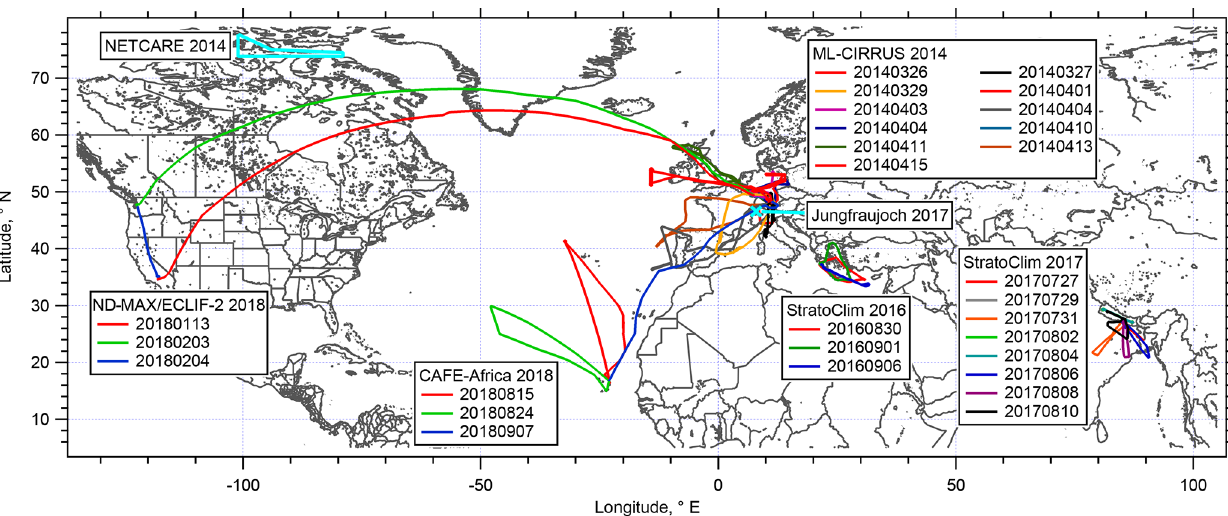
Figure 1. Map of the flight tracks of all UTLS research flights used in this study. Additionally the locations of the low-altitude measurements are indicated: Jungfraujoch (3600ma . s . l . ) and the operation range of the NETCARE (Network on Climate and Aerosols: Addressing Key Uncertainties in Remote Canadian Environments) flights (0–3000ma . s . l . ). Please note that dates in this figure are given in the format of year month day.